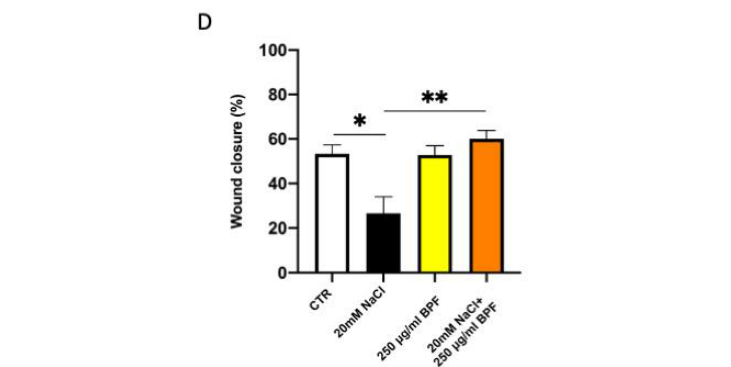
Figure 3. BPF rescues angiogenesis and promotes wound healing in SHRSP cerebral ECs exposed to high salt load. ECs were exposed to 20 mM NaCl for 72 h either in the presence or in the absence of 250 µg/mL BPF. CTR indicates nontreated cells. Representative images of Matrigel assay ( A ) and the quantification of master junctions ( B ); representative images of scratch wound-healing assay ( C ) and relative quantification of wound closure percentage ( D ). N = 3. * p < 0.05 and ** p < 0.01 obtained using one-way ANOVA followed by Bonferroni post hoc analysis. Data are reported as mean ± SEM.